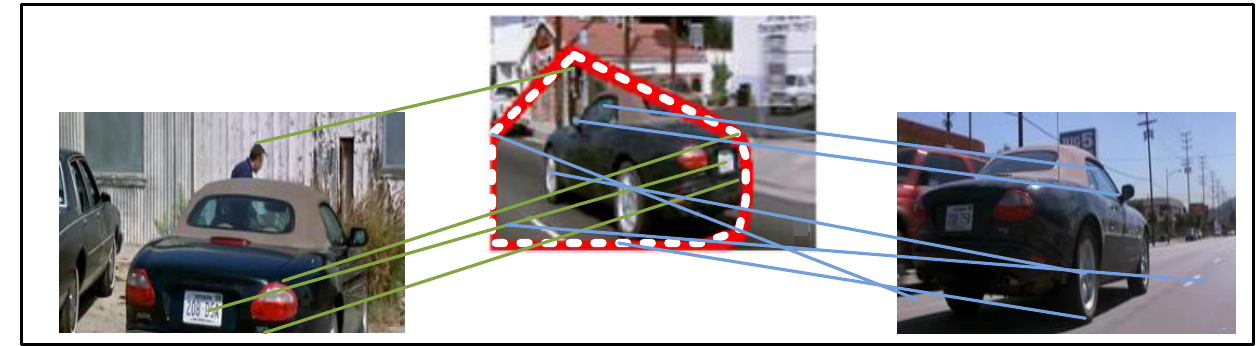
Figure 3. Automatic detection of object regions from a few